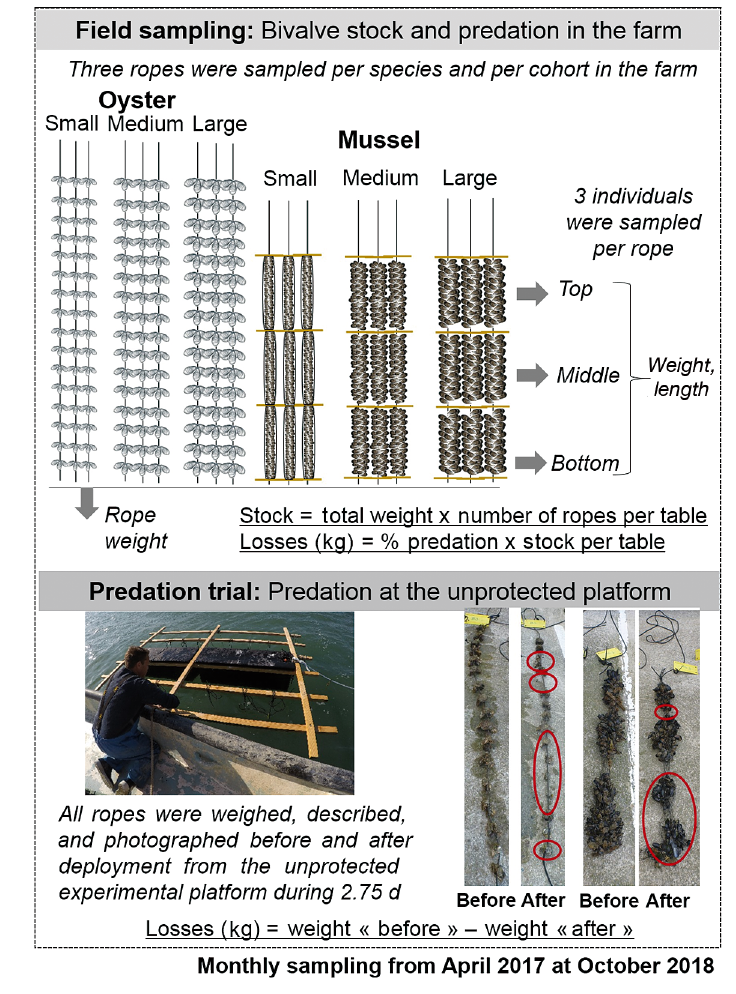
Fig. 3. Sampling design for field observations and predation trials to deter- mine monthly bivalve stocks and losses in the farm and at the unprotected platform between April 2017 and October